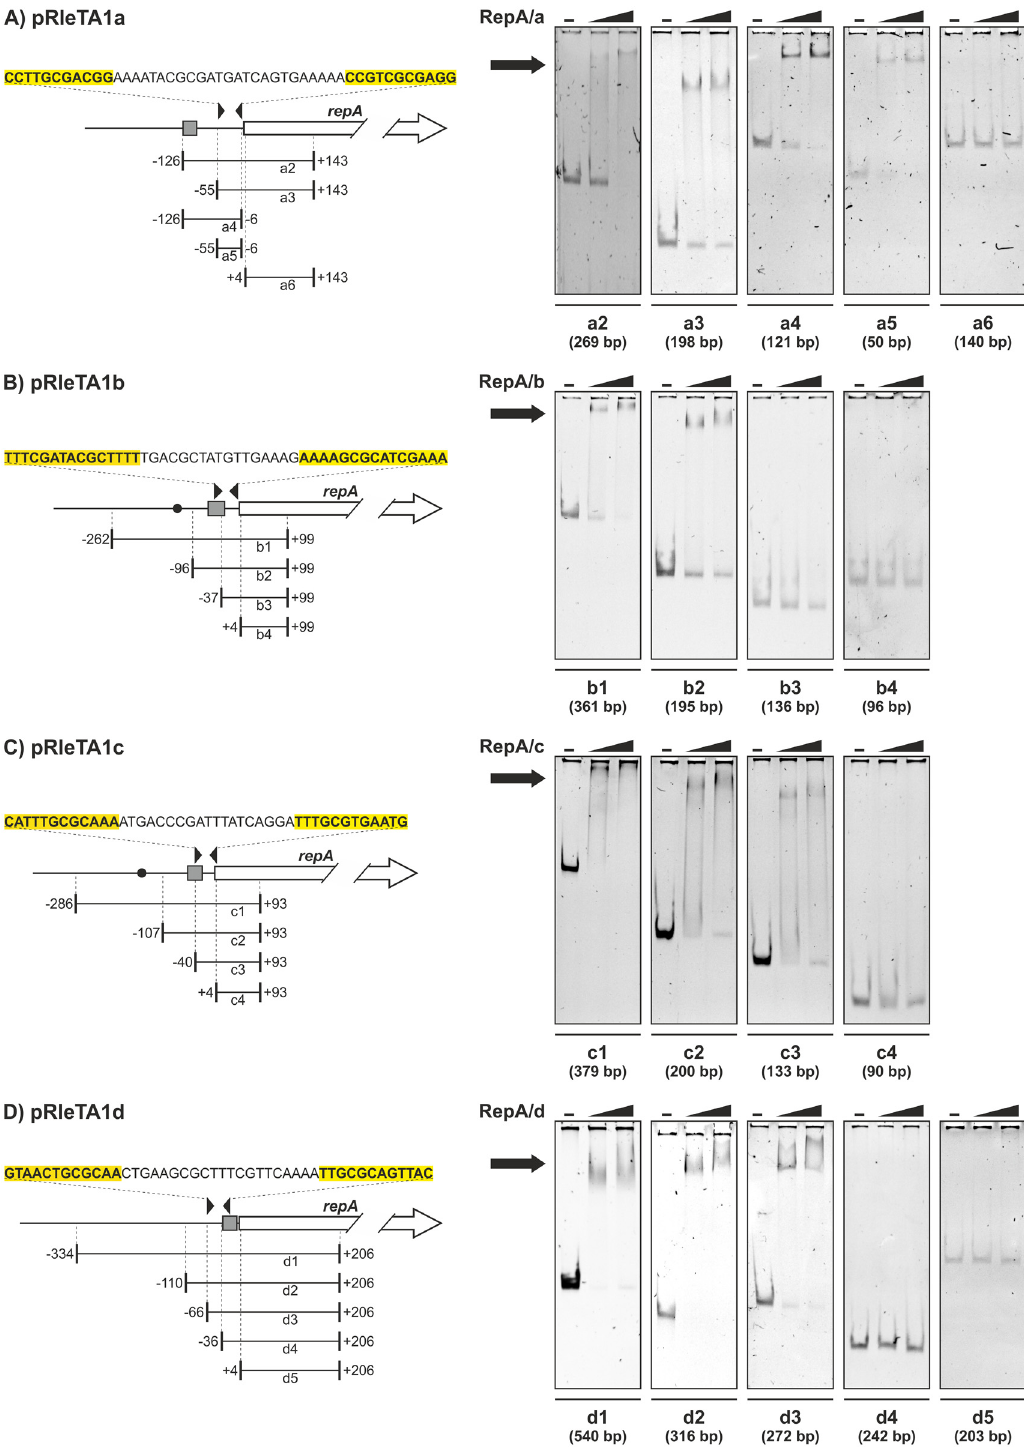
Fig 2. Mapping of operator sequences of repABC operons of RtTA1 plasmids: (A) pRleTA1a, (B) pRleTA1b, (C) pRleTA1c, and (D) pRleTA1d. Left panels show schematic depictions of the region upstream of repA of repABC operons. The respective promoters (grey rectangle), operators — imperfect palindromes (black inverted triangles), parS elements (black dots) and repA genes (white broken arrow) were shown. The sequence of each palindrome is highlighted in yellow. Length and relative position of DNA fragments used in operator (Op) mapping were shown with respect to repA start codon. Right panels represent EMSA results with recombinant His 6 -RepA and respective DNA fragments (5 – 25 ng). Black triangles indicate the increasing concentration of particular His 6 -RepA protein (10 and 100 pmol) present in DNA binding reaction. Black arrows indicate the position of the retarded DNA bands.